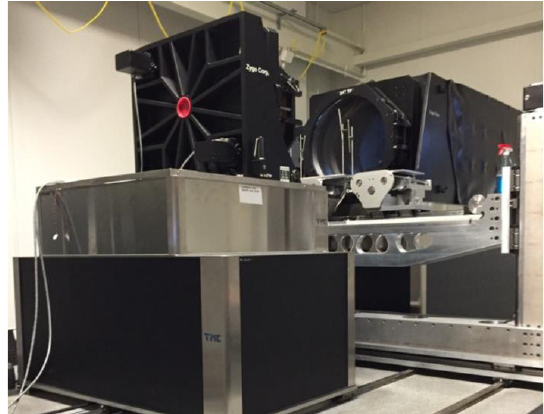
Fig. 1. Interferometer Zygo Verifire with 600 mm aperture at SCHOTT in Duryea with large casting of SCHOTT N-BK7 ® .